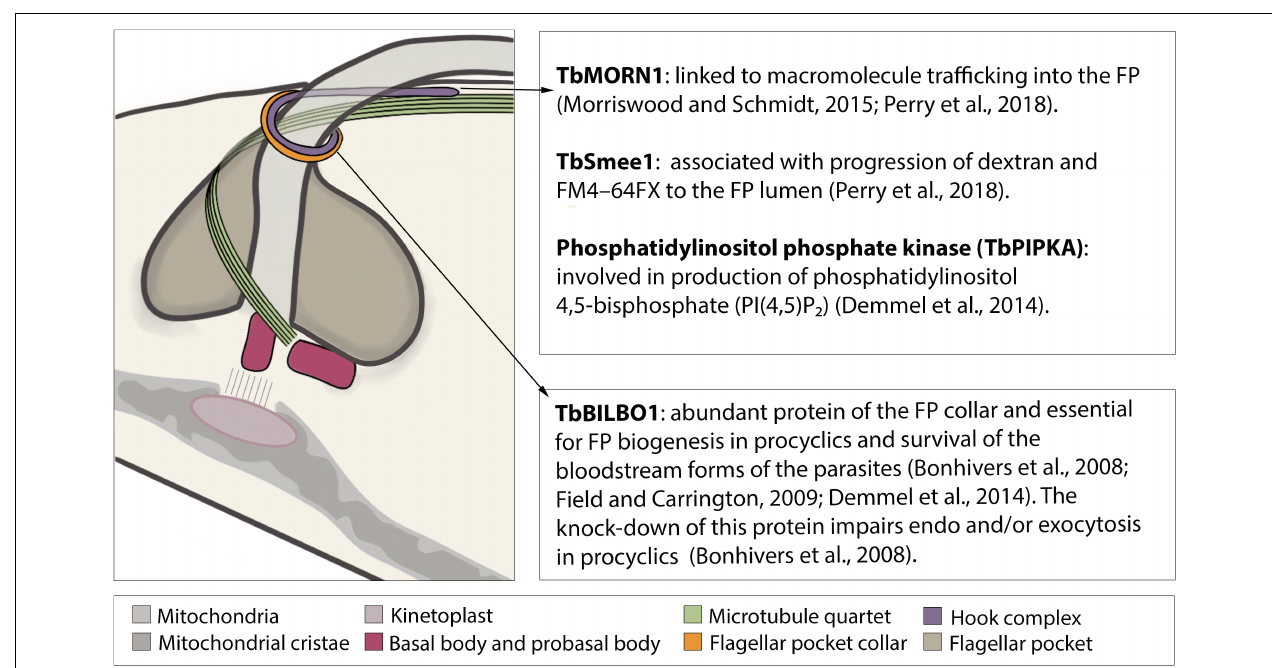
FIGURE 2 | Schematic structure of the flagellar pocket with emphasis on its cytoskeleton components involved in endocytosis. The flagellar pocket (FP) of Trypanosoma brucei is a subdomain of the plasma membrane, corresponding to approximately 2–5% of its total area (Grünfelder et al., 2002; Engstler et al., 2004; Field and Carrington, 2009). On its most external face lies the flagellar pocket collar (FP collar) of which TbBILBO1 is the main component (Sherwin and Gull, 1989; Bonhivers et al., 2008; Lacomble et al., 2009). On top of the FP collar lies the hook complex (HC), a multiprotein structure, of which three components (TbMORN1, TbSmee1, and TbPIPKA) have been shown to be involved in endocytosis (Morriswood et al., 2009; Zhou et al., 2010; Esson et al., 2012; Demmel et al., 2014; Morriswood and Schmidt, 2015; Perry et al., 2018; Sajko et al.,